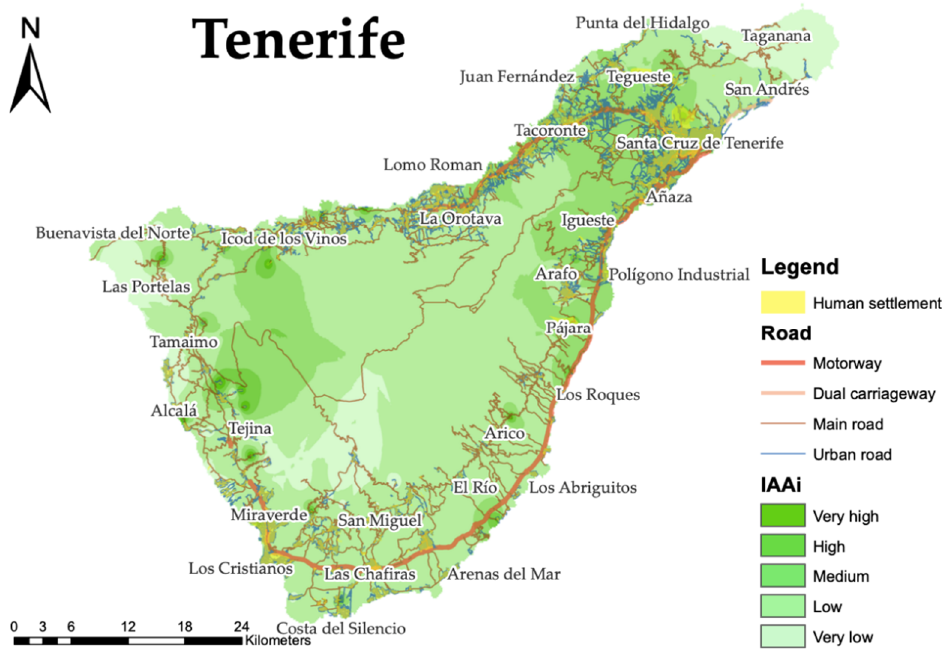
Figure 2. Thematic cartography regarding the accessibility levels in the Island of Tenerife (Source: authors).